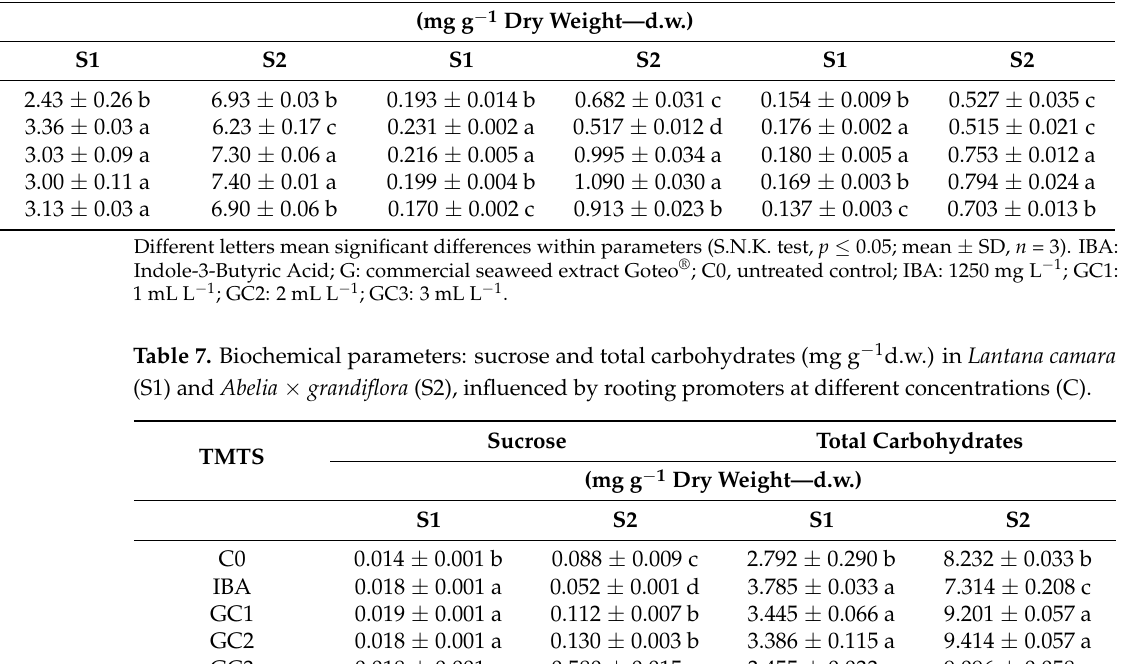
Table 6. Biochemical parameters: starch, glucose and fructose (mg g − 1 d.w.) in Lantana camara (S1) and Abelia × grandiflora (S2), influenced by rooting promoters at different concentrations (C). Starch Glucose Fructose TMTS (mg g − 1 Dry Weight—d.w.)